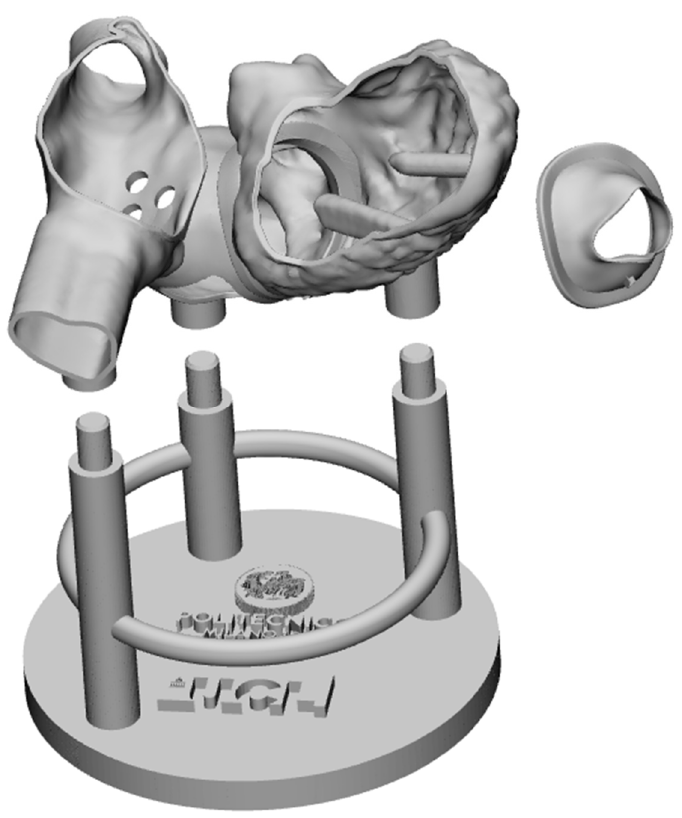
Figure 3. The digital model of the simulator, shown in an exploded view.